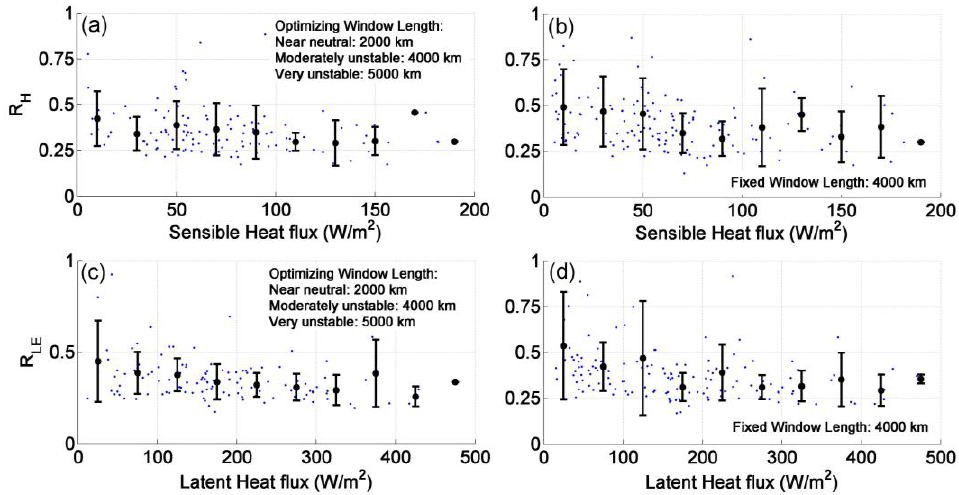
Figure 10. The relationship between the magnitude of heat fluxes and the relative flux uncertainties for sensible heat flux ( R H ; a , b ) and latent heat flux ( R LE ; c , d ) based on optimizing ( a , c ) and fixed ( b , d ) window length. The black error bars show the mean (dark spot) plus/minus one standard deviation (horizontal bars) of relative flux uncertainty for 10 evenly spaced bins of flux magnitude.